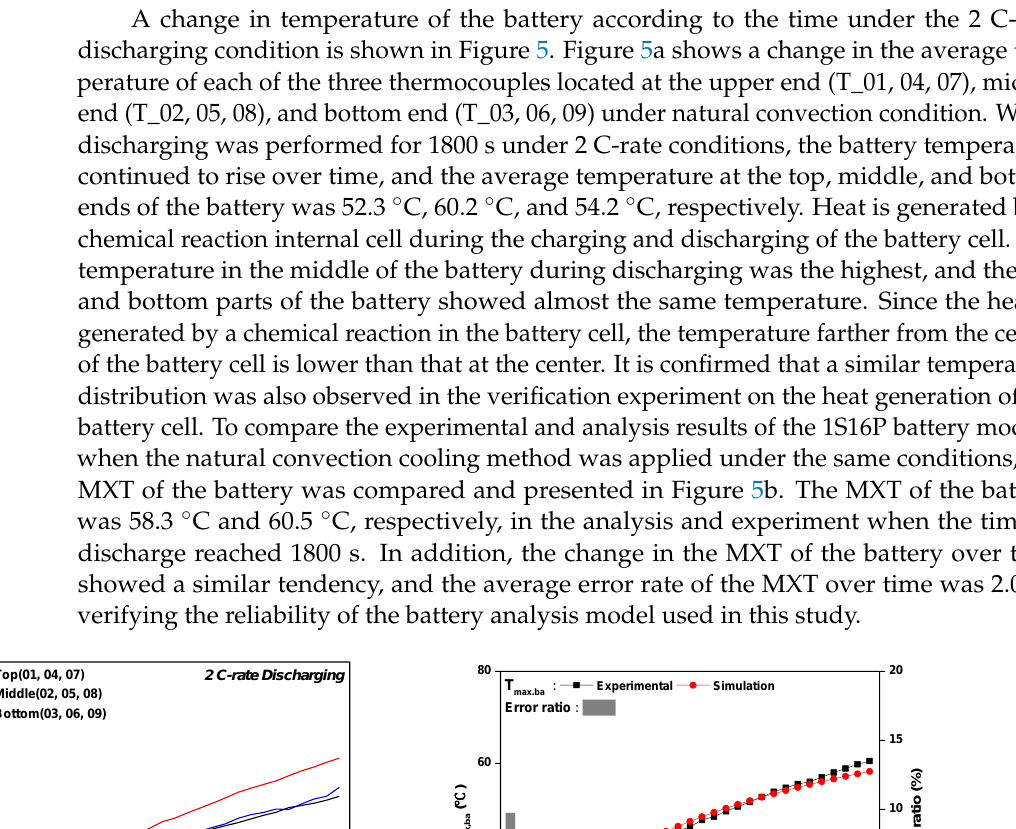
Figure 4. Verification experimental setup: ( a ) Schematic diagram of experimental setup; ( b ) 1S16P battery module.